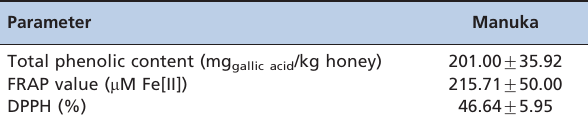
Table 1 - Total phenolic content, FRAP value and antiradical power (1,1-diphenyl-2-picrylhydrazyl) of manuka honey.